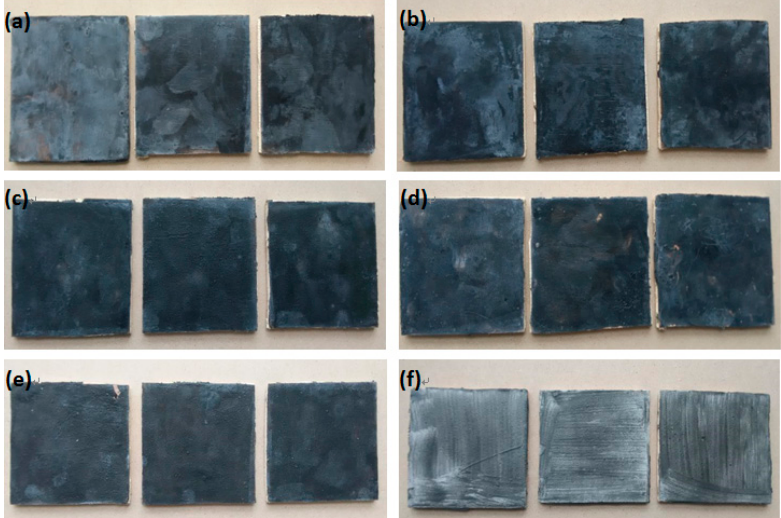
Figure 2. Appearance of specimens before combustion including ( a ) S0, ( b ) S1, ( c ) S2, ( d ) S3, ( e ) S4, ( f ) S5.